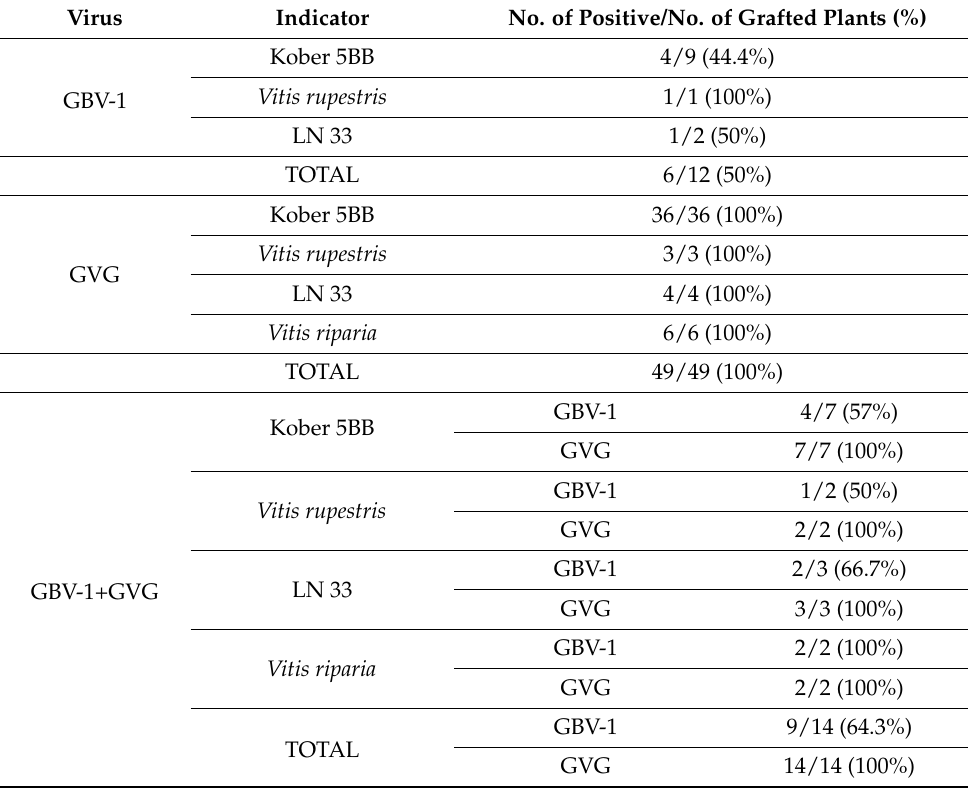
Table 2. Graft transmission results for GBV-1 and